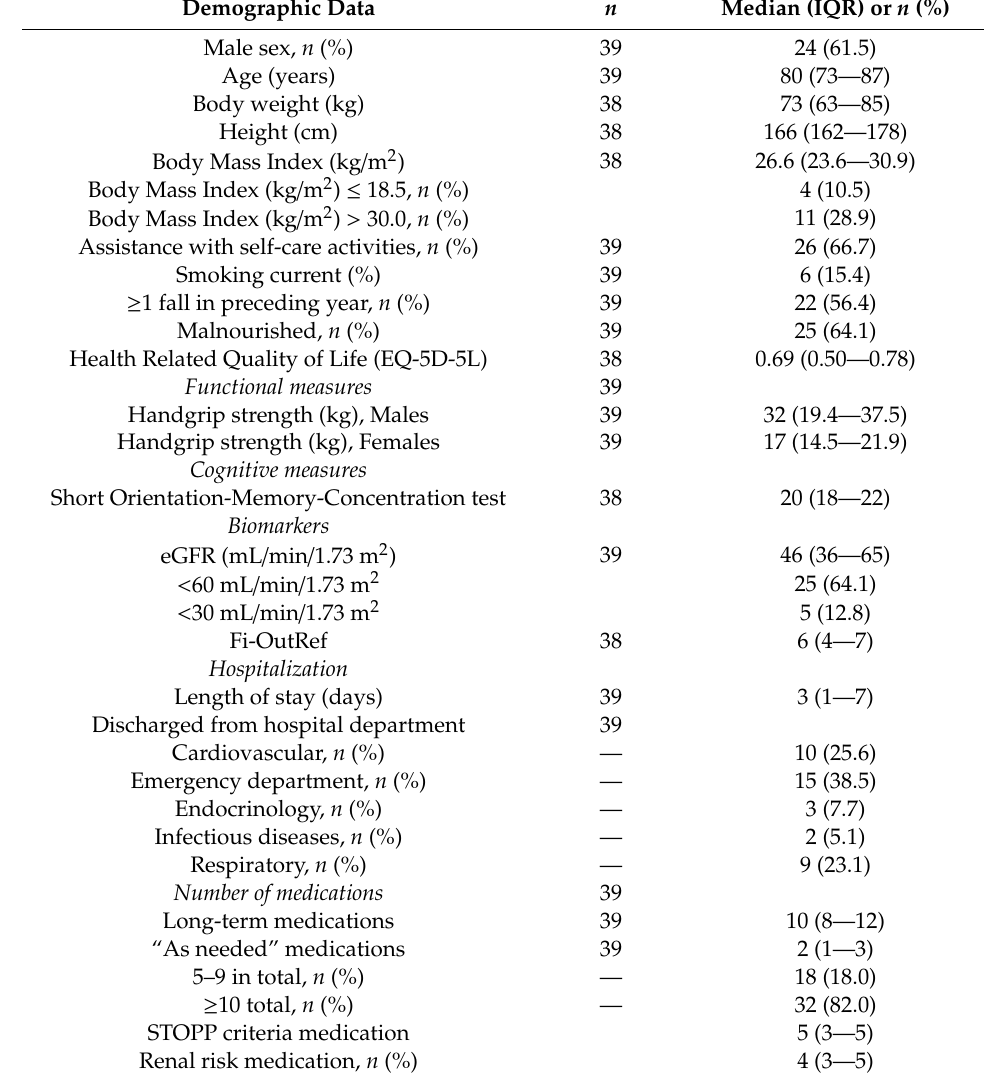
Table 1. Characteristics of the included older medical patients ( n =